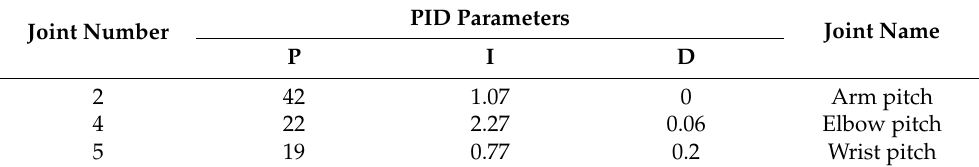
Table 3. PID parameters of each joint in the test. Joint